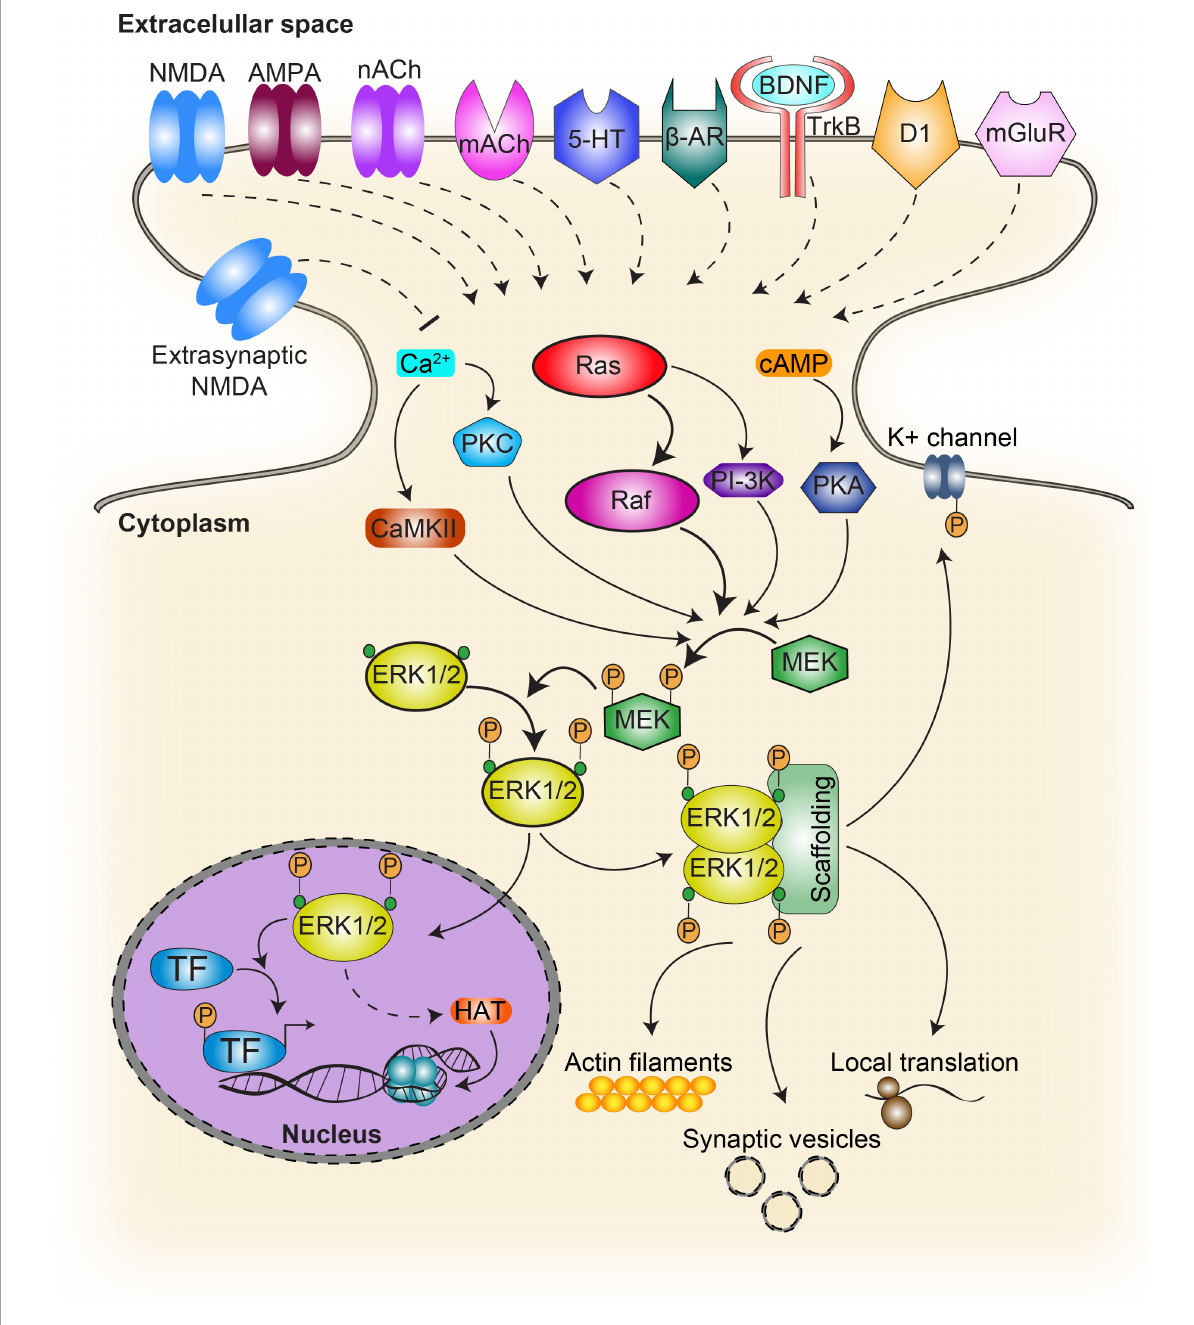
FIGURE1 Schematic diagram of the activation pathways and targets of ERK. In the classical ERK cascade, activation of the receptor upon ligand binding results in the recruitment of the Ras family protein activating Raf. This step initiates the sequential phosphorylation of MEK which in turn activates ERK. Phosphorylated ERK targets cytosolic as well as nuclear substrates. Several other signaling pathways contribute to ERK activation. G-protein coupled receptors prompt the intracellular production of cAMP and calcium, while calcium can also increase intracellularly through ionotropic receptors. While cAMP contributes to ERK activation through PKA, calcium does it by molecules such as PKC and CaMKII. NMDA, NMDA receptors; nACh, nicotinic acetylcholine receptor; mACh, muscarinic acetylcholine receptor; 5-HT, serotonin receptor; β -AR, beta adrenergic receptor; BDNF, brain-derived neurotrophic factor; TrkB, tropomyosin receptor kinase B, also known as tyrosine receptor kinase B; D1, type 1 dopamine receptor; TF, transcription factors such as CREB and Elk1; HAT, histone acetyltransferase. Continuous lines indicate direct action while dash lines indicate indirect